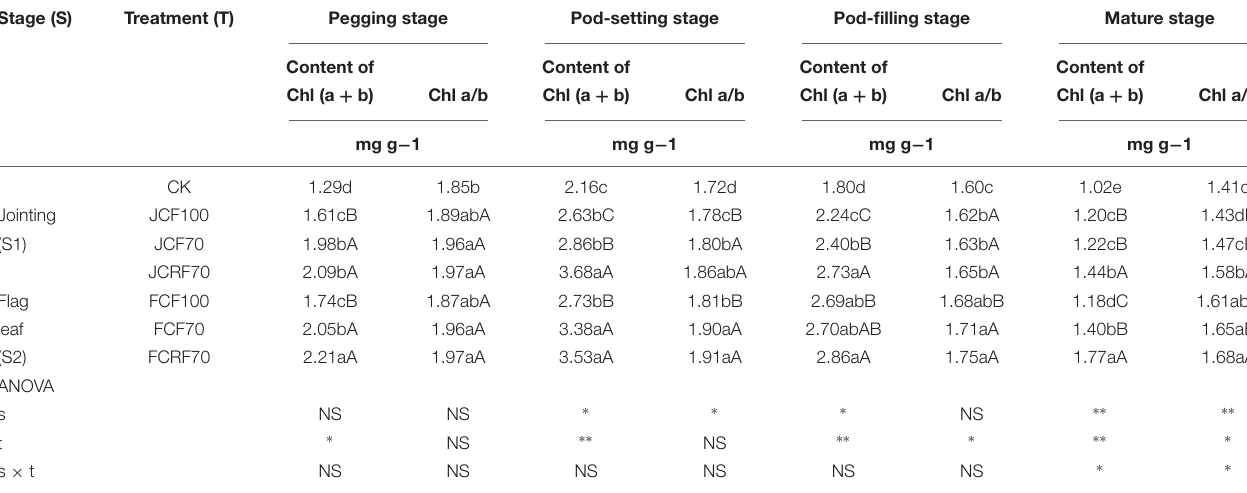
TABLE 3 | Effect of different N fertilizer management regimes on the chlorophyll content and Chl a/b of peanut. Stage (S)